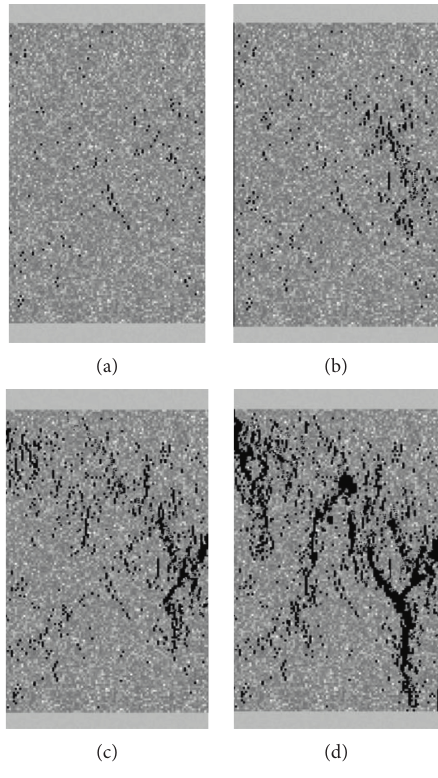
Figure 2: Failure process of a rock model under uniaxial compression.